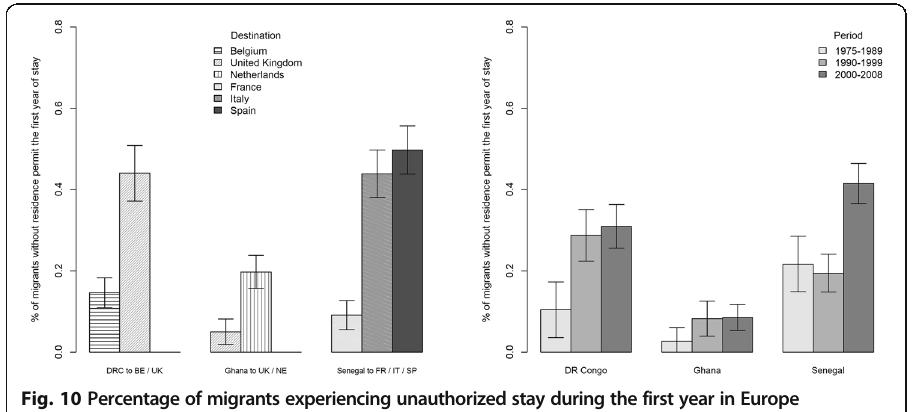
Fig. 10 Percentage of migrants experiencing unauthorized stay during the first year in Europe (1975 – 2008), by origin, country of residence (at the time of the survey), and period of arrival. Source: MAFE Biographical Surveys in Europe. Measure: Percentage of migrants who declared that, during the first year in the country of residence, they did not have a residence permit at some point. This is not synonymous with illegal entry: a person may have entered legally, with a visa that expired. Weighted results, 90% confidence